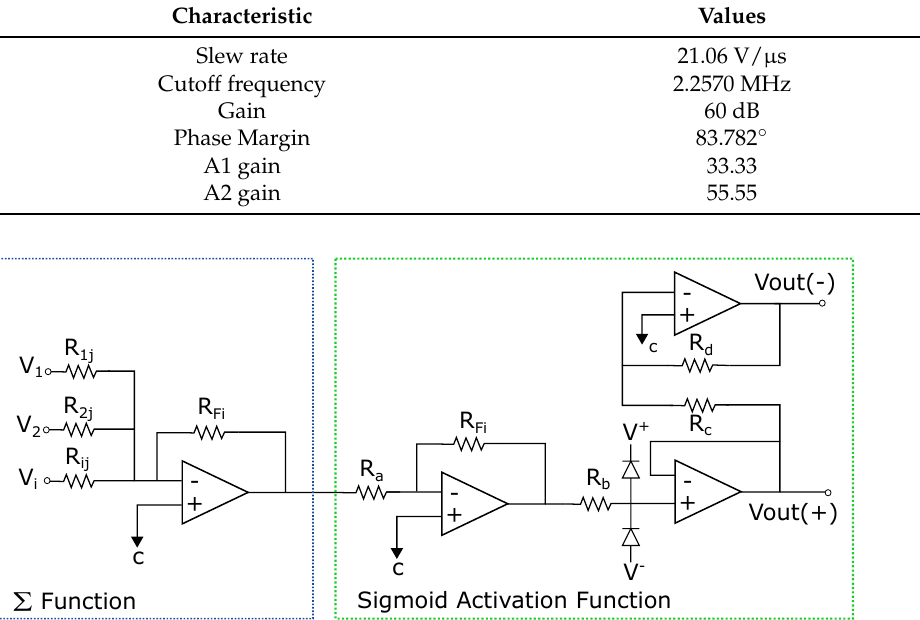
Table 5. Characteristic Values of the CMOS integrator circuit.